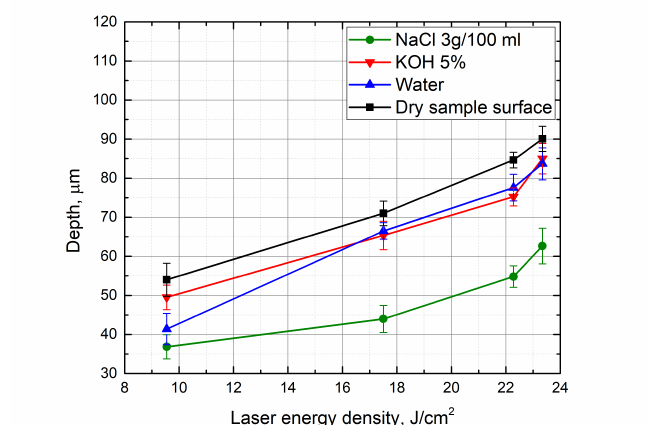
Figure 2. Depth of the grooves formed in the glass sample in dependence on the laser energy density. Grooves were formed while the glass sample surface was dry and immersed in different